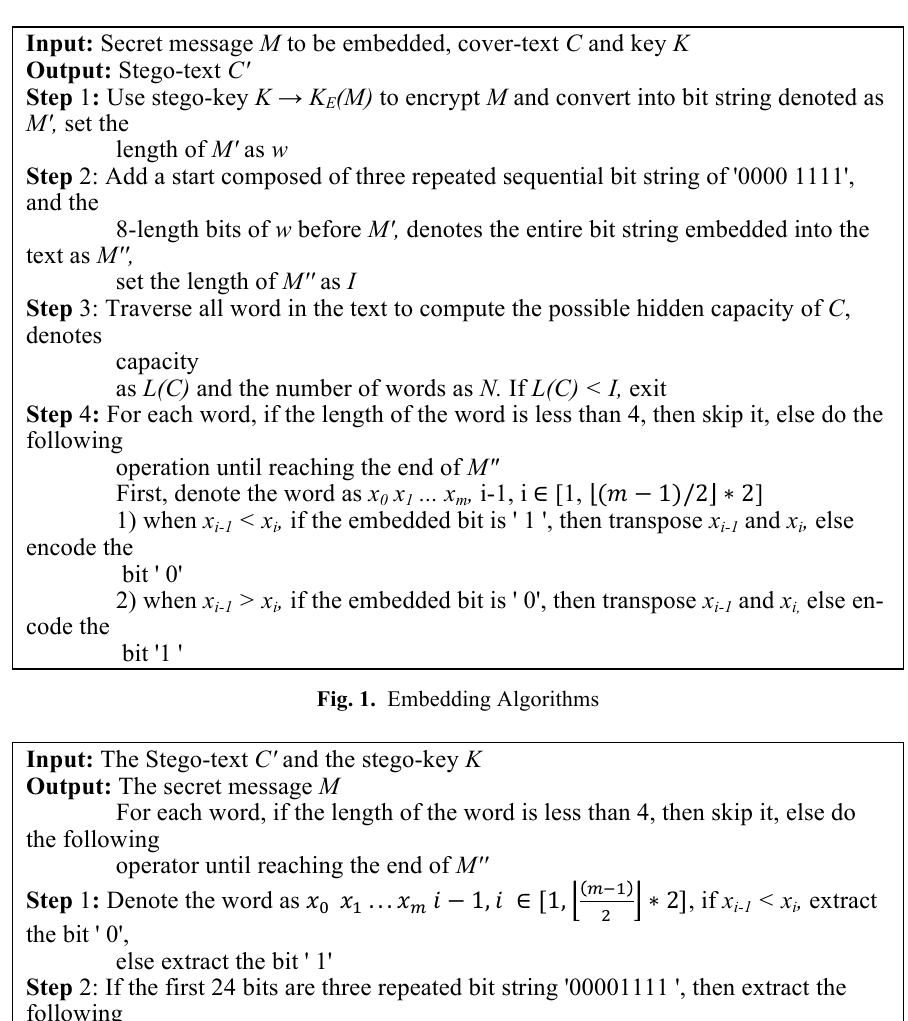
Short Paper— A Text Steganographic System Based on Word Length Entropy Rate